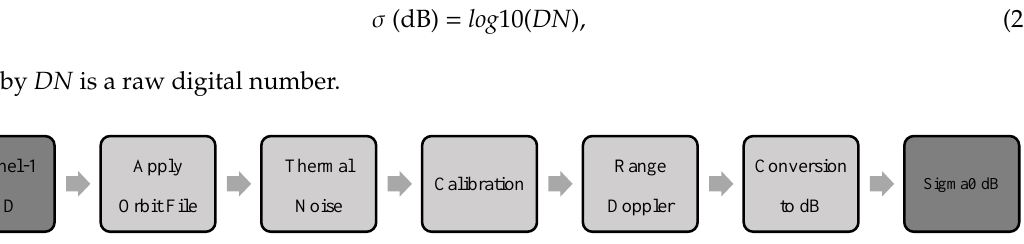
Figure 5. Sentinel 1 ground range detection (GRD) pre-processing workflow, adapted from [39]. Apply Orbit